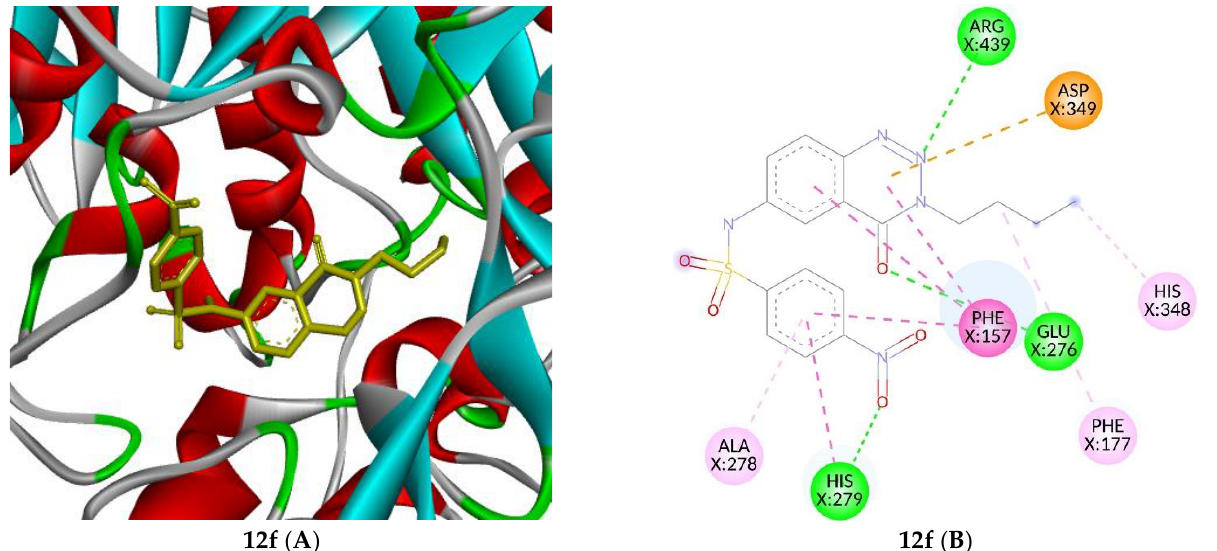
Figure 4. 2D ( B ) and 3D ( A ) structures illustrating docking results, ligand 12f within alpha-gluco- sidase develops interactions shown by colored lines; hydrogen bonding (green), pi-cationic/pi ani- onic interaction (brown), pi-pi interaction (pink) and pi-alkyl interaction (purple). Similarly, the benzotriazinone ring of both ligands ( 12e and 12f) depicted